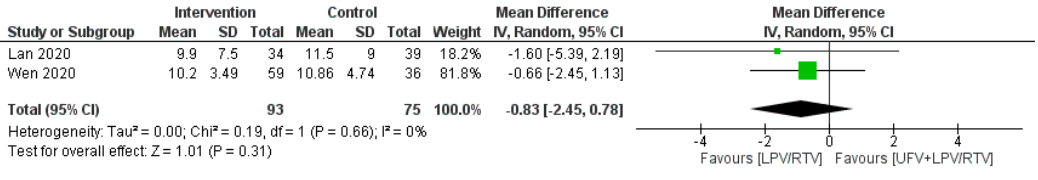
Figure 4. Time from +ve to − ve PCR (days) (LPV/RTV vs LPV/RTV plus umifenovir combination). CI,